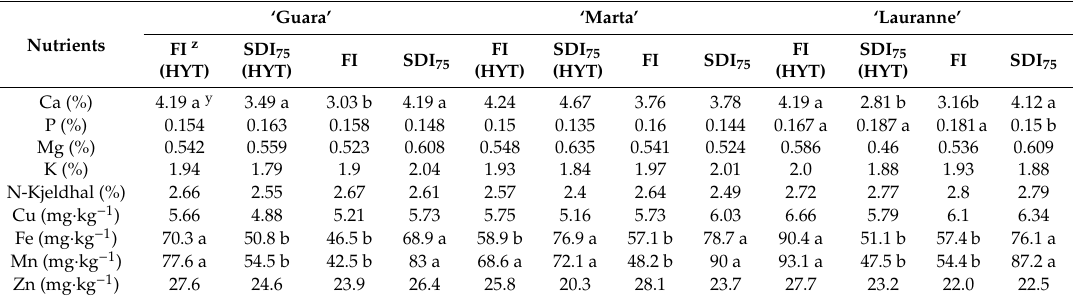
Table 5. Average foliar mineral content for almond cultivars subjected to irrigation and fertilization treatments. ‘Guara’ Nutrients